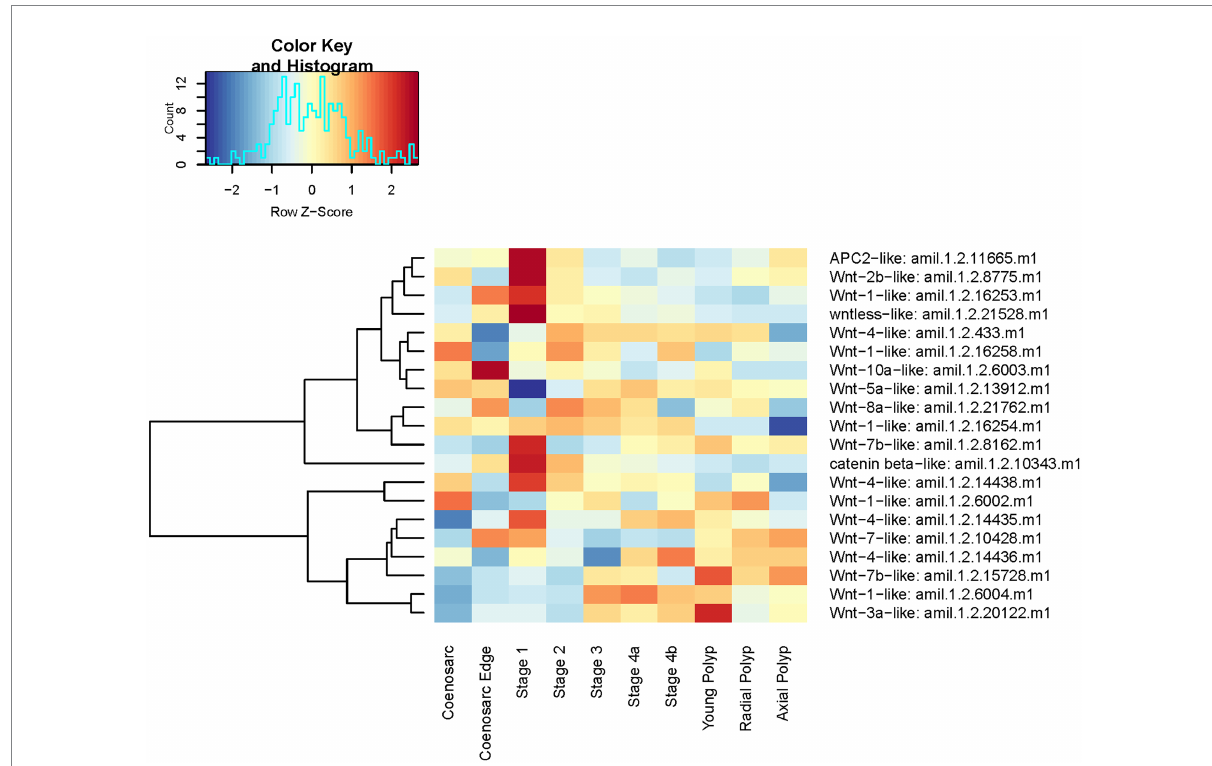
FIGURE 9 Expression heatmap of A. millepora Wnt genes and core components of the Wnt pathway. Samples are pooled according to regeneration stage and morphologically distinct colony part. Colour denotes an increase (red) or decrease (blue) in expression based on the z-score. The Histogram shows the distribution of the z-scores on the heatmap.